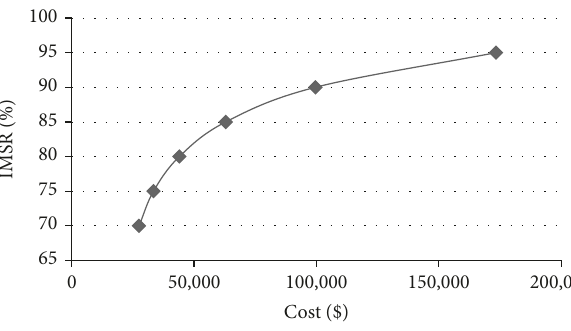
Figure 6: Cost of increasing the IMSR.